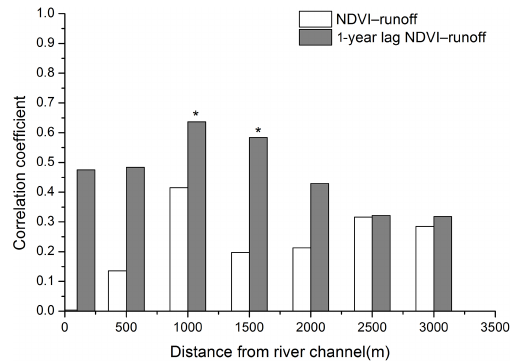
Figure 6. Pearson correlation coefficients of NDVI–runoff and 1- year lag NDVI–runoff at different distances from the river channel. Note: ∗ above the bar indicates significant correlations ( P <